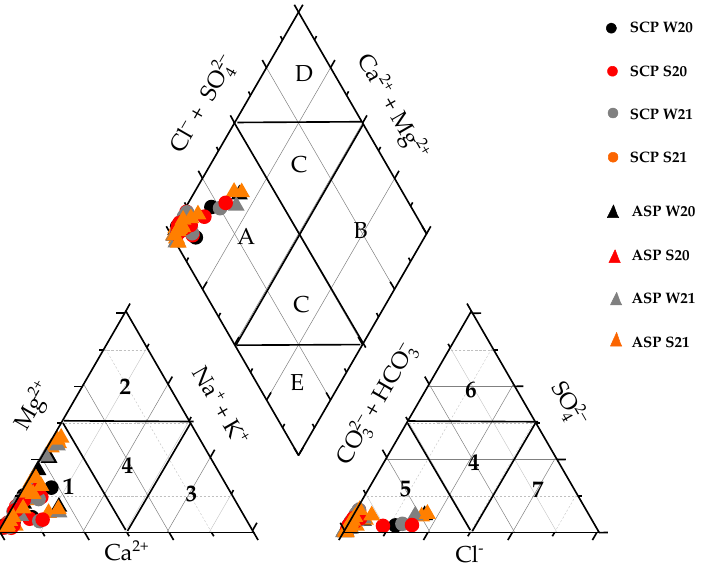
Figure 5. Piper diagram illustrating the water facies (A—Magnesium bicarbonate type, B—Sodium chloride type, C—Mixed type, D—Calcium chloride type, and E—Sodium bicarbonate type; 1—Calcium type, 2—Magnesium, 3—Sodium and potassium, 4—Non dominant type, 5—Bicarbonate type, 6—Sulphate type, and 7—Chloride type). Water 2023 , 15 , x FOR PEER REVIEW 11 of 18 The Ca/Mg molar ratio in the groundwater ranged between 3.40 and 44.3 in the SCP region and between 1.26 and 46.2 in the APS area, with low seasonal or annual fl uctua- tions. The high variability of the Ca/Mg molar ratio between the groundwater samples indicates various Ca and Mg sources, including carbonates and silicates, as well as a dif- ferent residence time of the water in the karst system [11]. The Ca/Ca+Mg molar ratio of 0.5 corresponds to the dissolution of dolomite, while a molar ratio of 1 corresponds to calcite dissolution [56]. The Ca/Ca+Mg ratios varied between 0.77 and 0.98 for the SCP region and between 0.56 and 0.98 for the APS region, with only very small annual and seasonal di ff erences. In the current study, the high values of the Ca/Ca+Mg molar ratio indicate the predominance of calcite dissolution over dolomite dissolution in both areas.